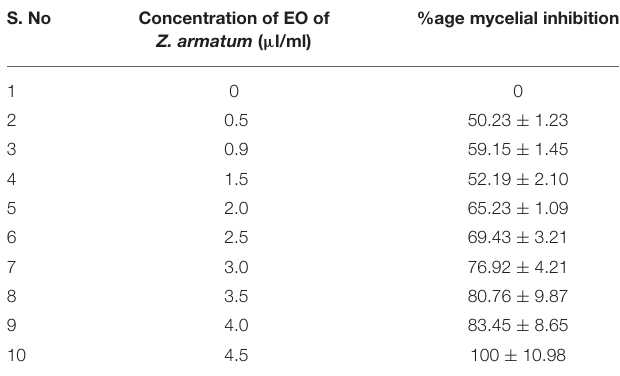
TABLE 1 | Chemical characterization of Zanthoxylum armatum DC essential oil by GC-MS analyses. S. No